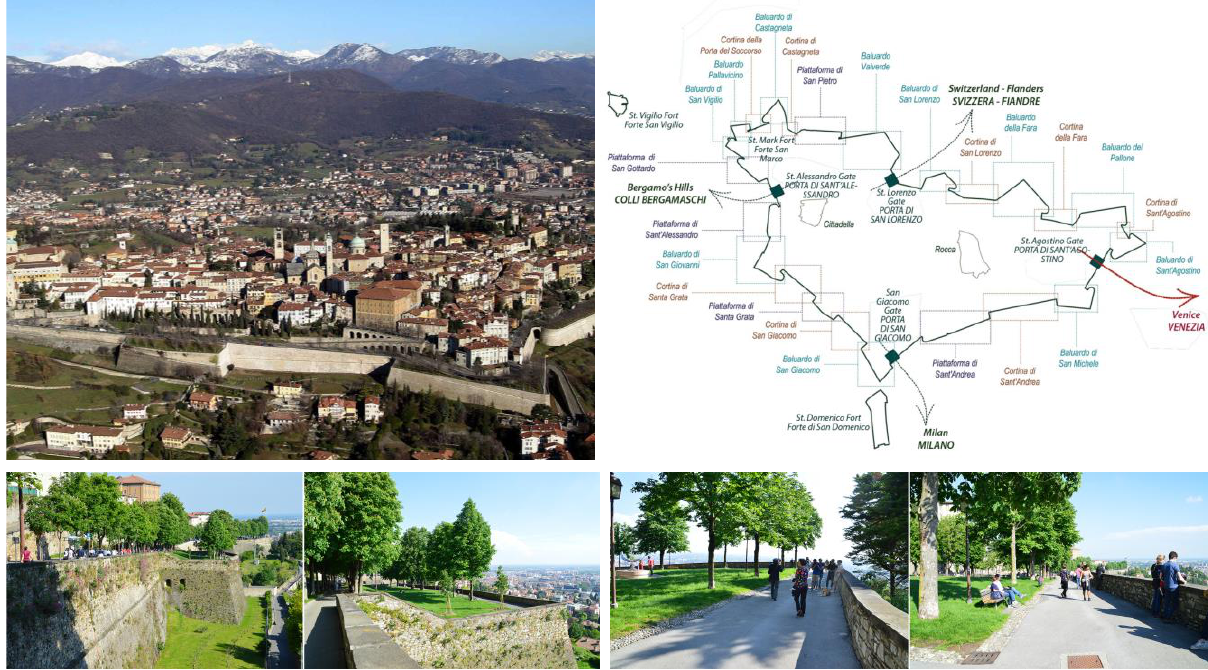
Figure 1. Aerial view form the South of Bergamo city walls and the names of the different portions of the circle. On the bottom, different sightseens from the promenade (Campus et al.